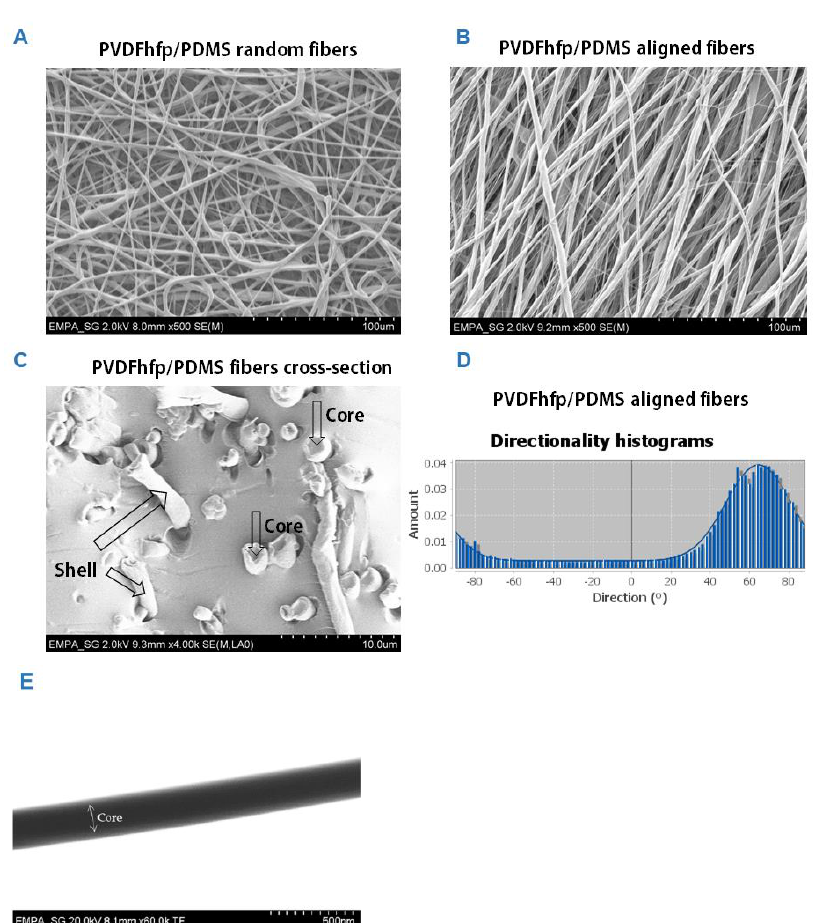
Figure 2. Scanning electron microscopy images (SEM) of random PVDFhfp/PDMS fiber mesh ( A ) and aligned fiber mesh ( B ); cross-section of core–shell fibers, with cores and shells depicted by arrows ( C ) and angles of directionality for aligned fibers ( D ). The fiber diameters were 32.0 ± 10.9 μm, while they were 33.0 ± 10.6 μm for the random and aligned fibers, respectively. TEM picture of core–shell structure ( E ). A white arrow with two arrowheads marks the core. The shell can be seen as a slightly brighter grey border.